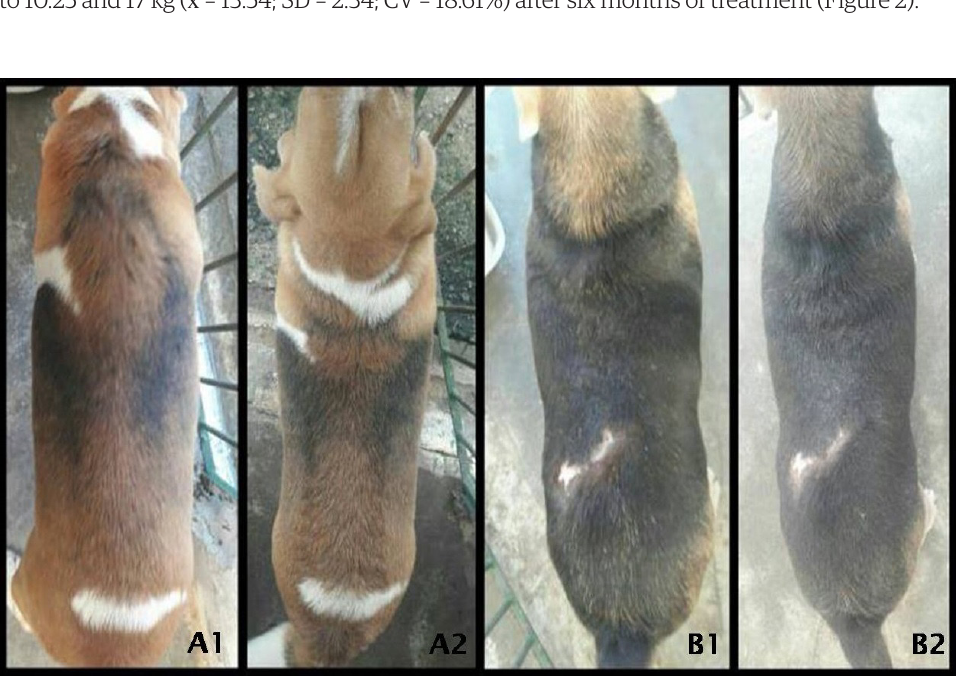
Figure 2. Dorsal view of two Beagle dogs included in the low-calorie diet before (A1 and B1) and after six months before of the treatment (A2 and B2). Source: Service of Cardiology and Respiratory Diseases -